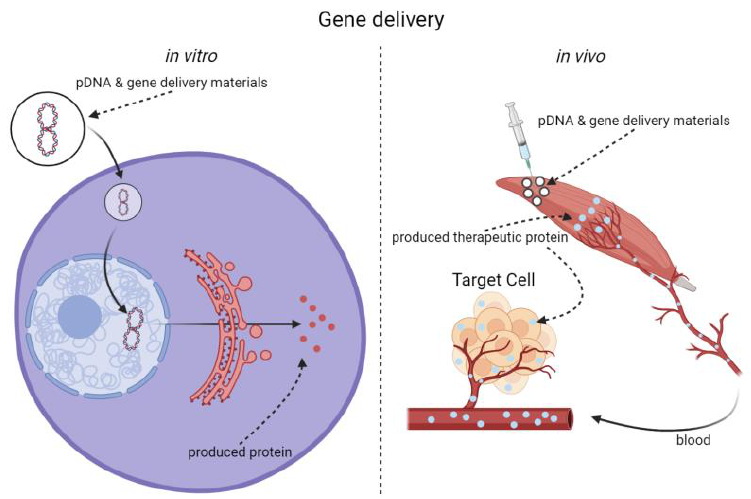
Table 1. Polymers for gene delivery to skeletal